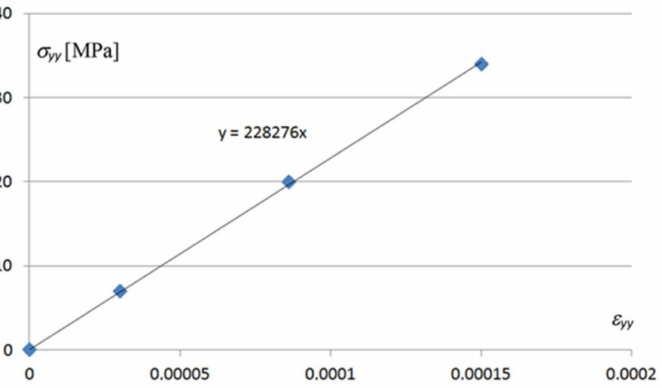
Figure 26. A linear relation between the σ yy normal stresses and the ε yy corresponding strains appearing at a point located at the crosswise end of a shell